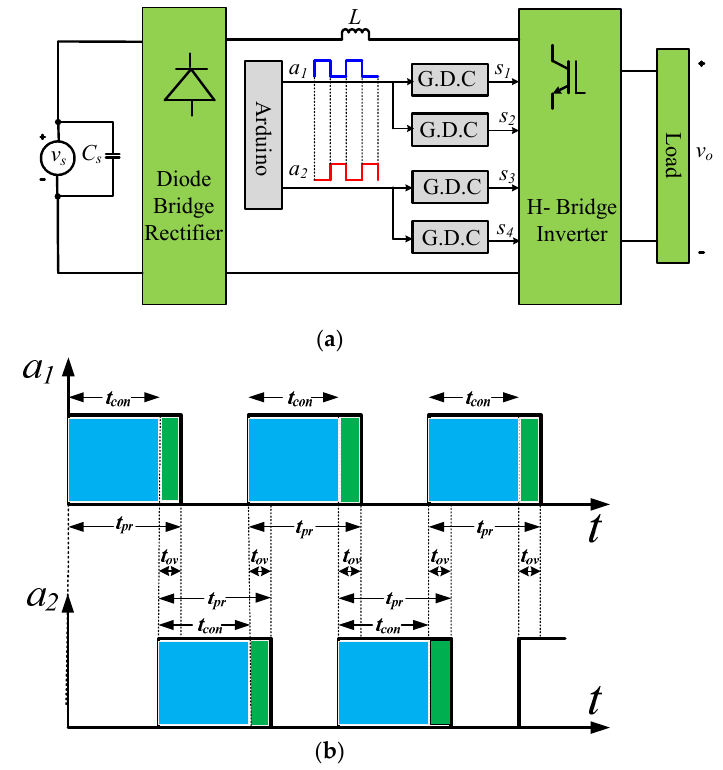
Figure 4. ( a ) Block diagram of the suggested converter topology; ( b ) gating signals.